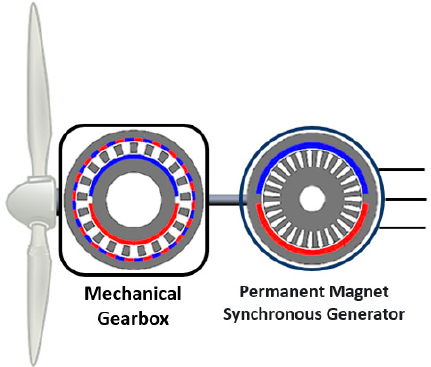
Figure 16. Illustration of the powertrain in a wind turbine. Conventional scheme: magnetic indirect drive.